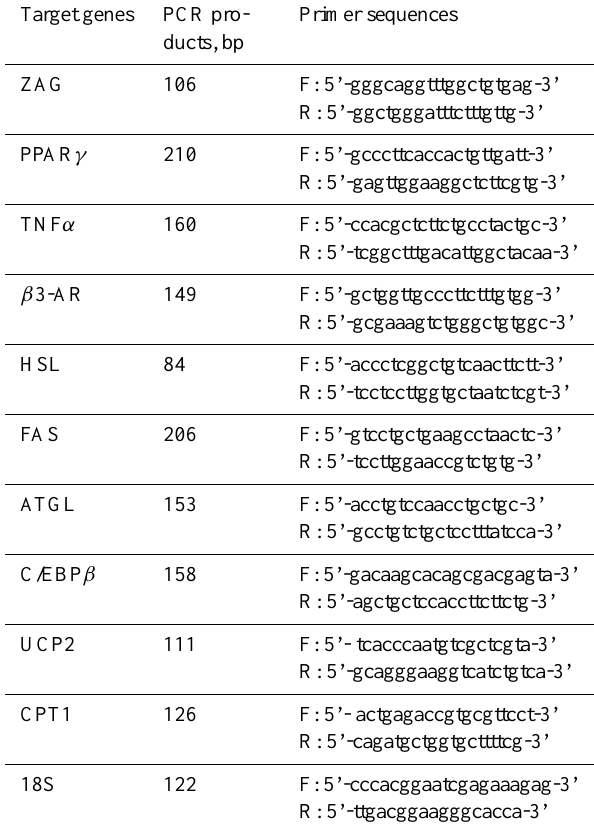
Table 1. The primer sequences of the target